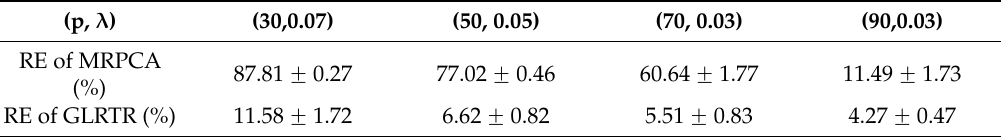
Table 3. Comparison of experimental results on incomplete 50 ˆ 50 ˆ 50 tensors for r = 5.